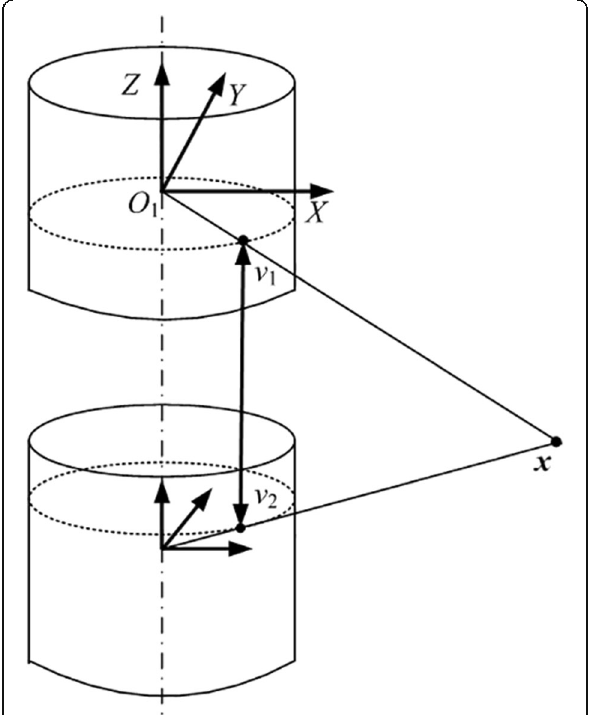
Fig. 6 Standard, vertically aligned, stereo vision